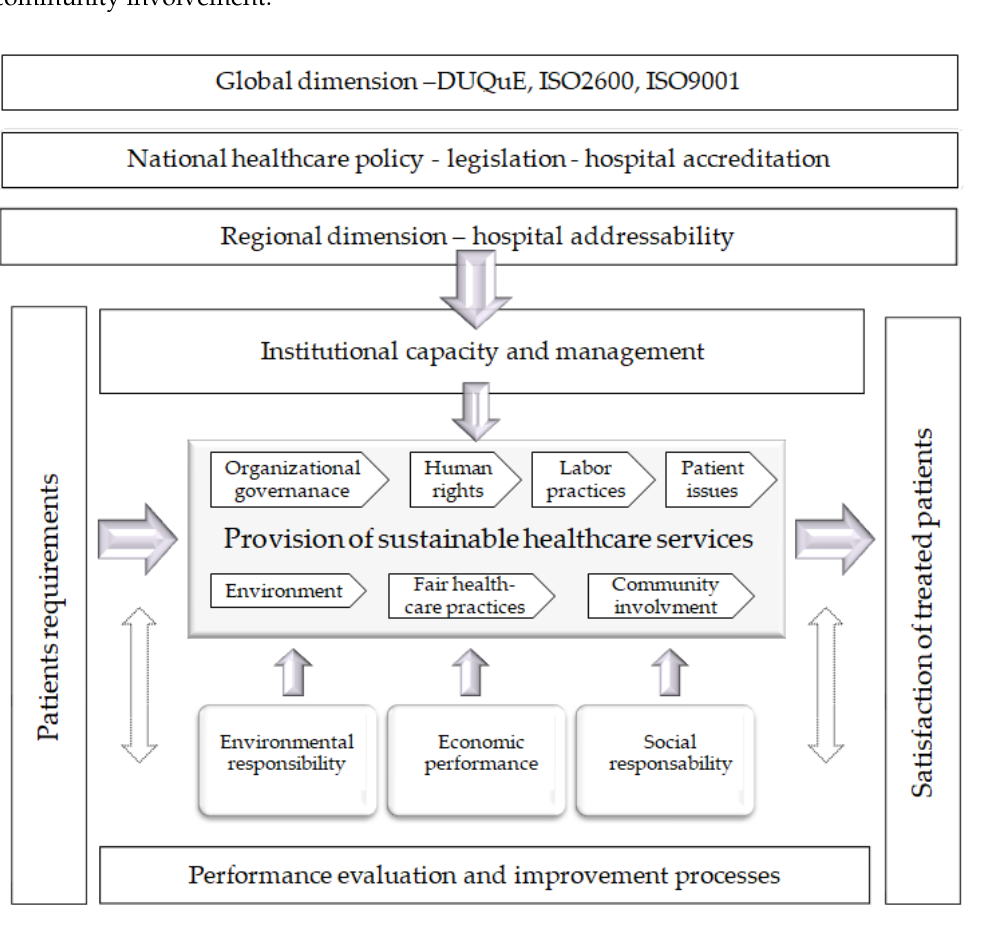
Figure 2. The sequence and interaction of the H-S core activities that make up the quality cycle.